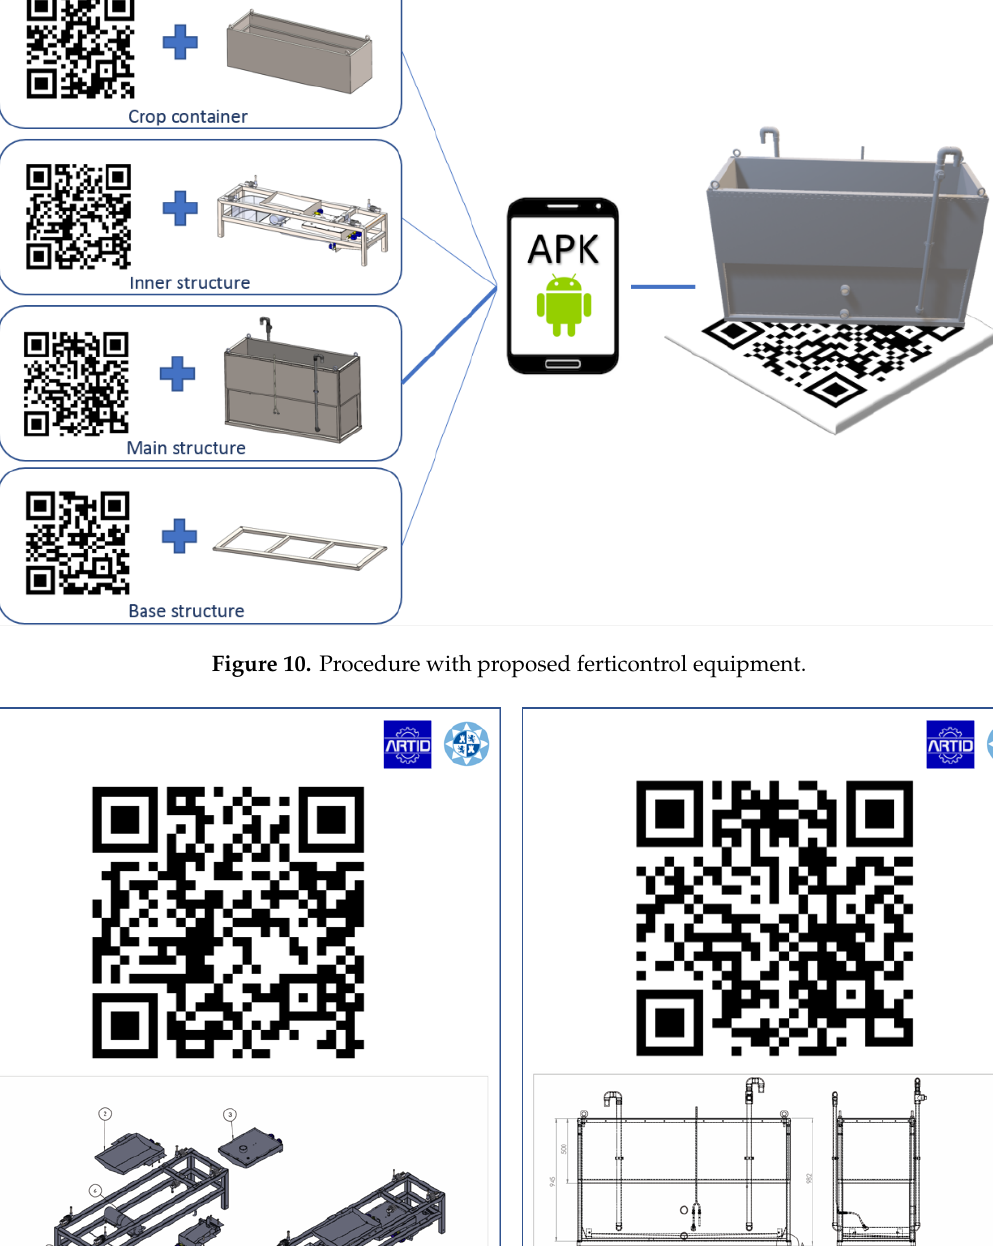
( b ) Figure 12. Viewing two ferticontrol equipment structures with the Augmented Reality for Teaching, Innovation and Design (ARTID) application: ( a ) inner structure; ( b ) main structure. 5. Discussion